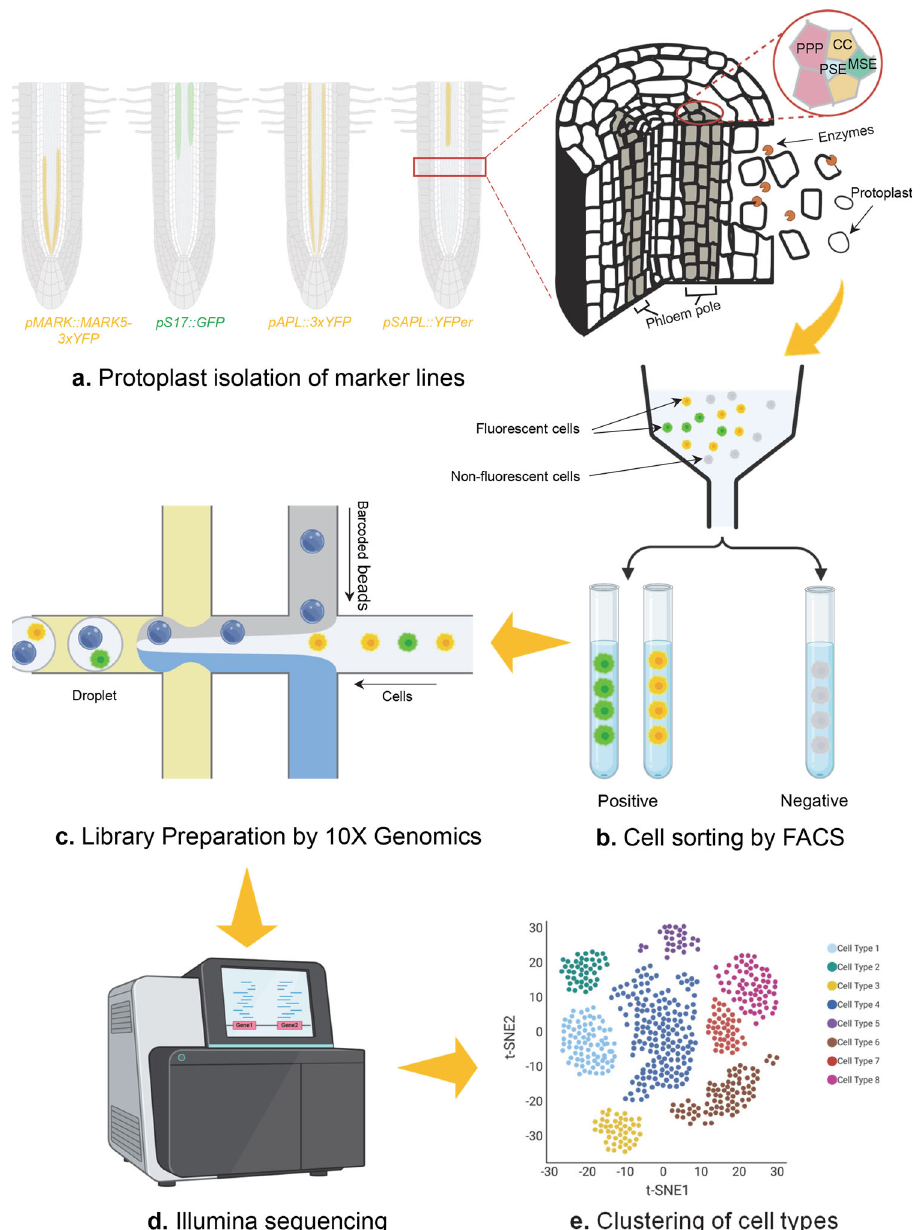
Fig. 1 Work fl ow of second-generation scRNA-seq. Cells derived from marker lines specifying cell identities are dissociated via protoplast isolation ( a ), followed by fl uorescence-activated cell sorting (FACS) to enrich target positive cells and eliminate unwanted negative cells ( b ). Positive cells collected are later used to prepare cDNA library within individual droplet ( c ) and subsequently got sequenced ( d ). Based on transcriptomic data coming from single cells, cell identities and development atlas are fi nally pro fi led ( e